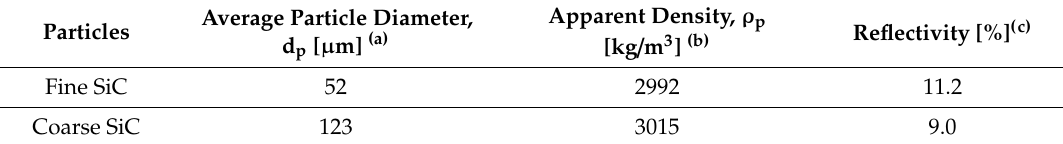
Table 1. Physical properties of SiC (Silicon carbide) particles used in the study. Apparent Density, ρ p Average Particle Diameter, Particles Reflectivity [%] (c) d p [ µ m] (a) [kg / m 3 ] (b) Fine SiC 52 2992 Coarse SiC 3015